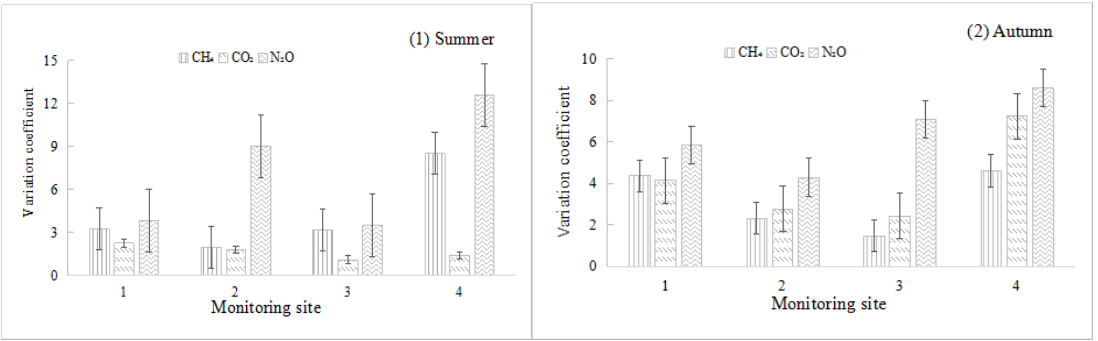
Figure 3. Spatial distribution of variation coefficient (VCs) of three GHGs in four monitoring sites in Huoshaogou River.